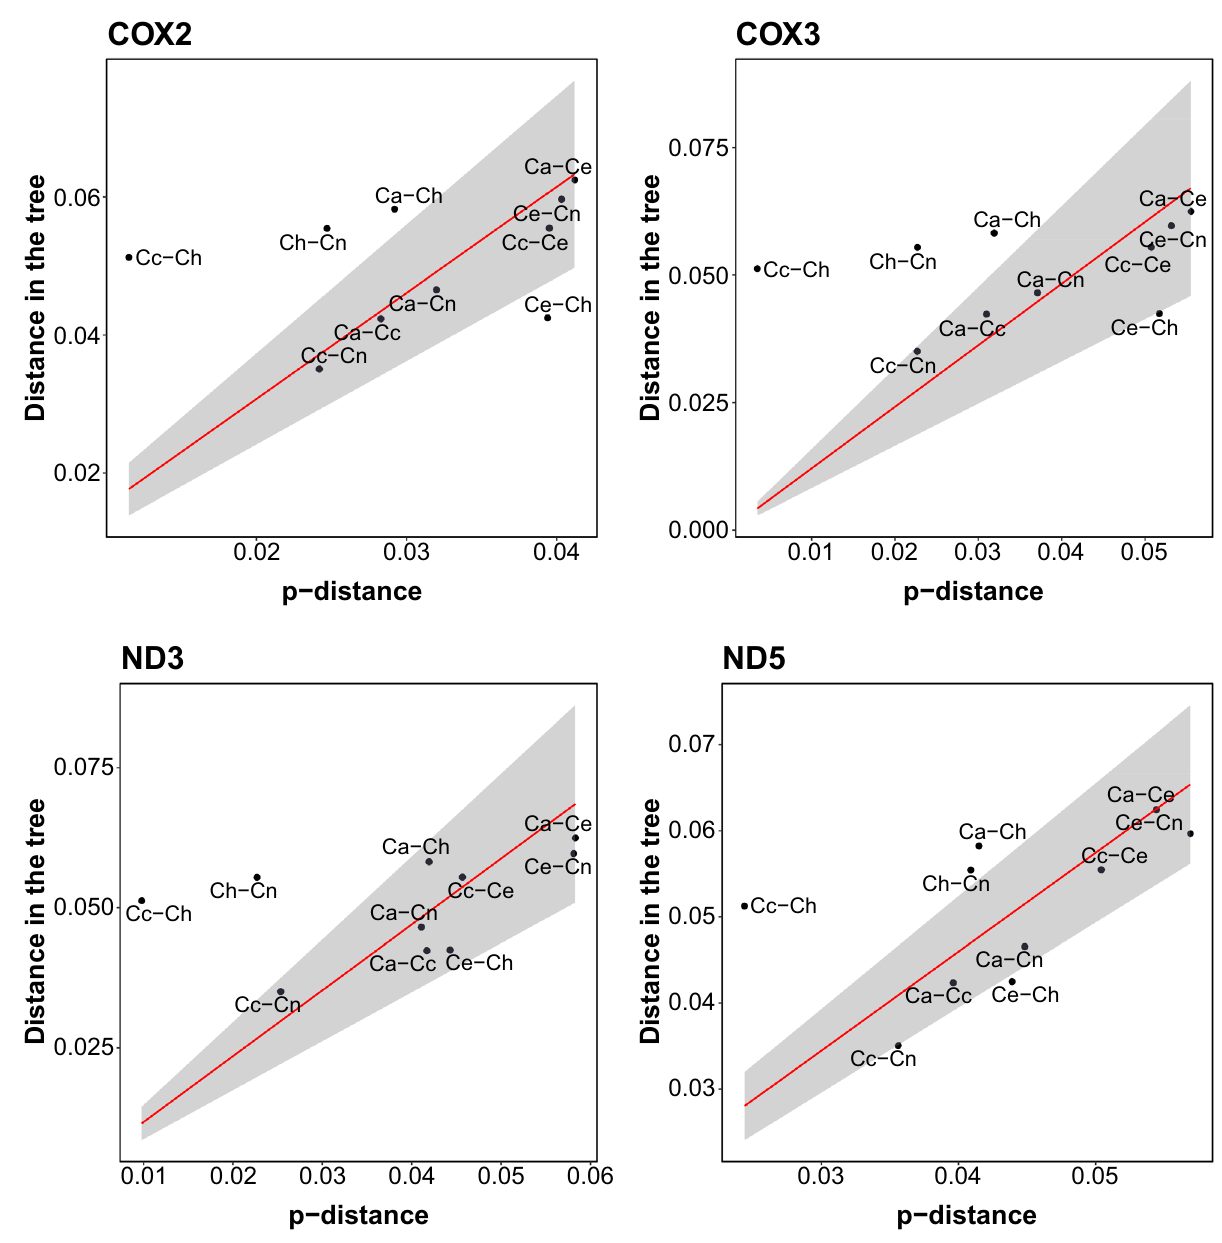
Figure 4. Relationships between the distances in the MrBayes phylogenetic tree and p-distances for all pairs of Cervus species and selected protein-coding genes. A regression line (red line) with 95% confidence interval (grey area) is shown. Ca— C. albirostris ; Cc— C. canadensis ; Ce— C. elaphus ; Ch— C. hanglu ; Cn— C. nippon. The plots for other genes and the control region are shown in Fig.